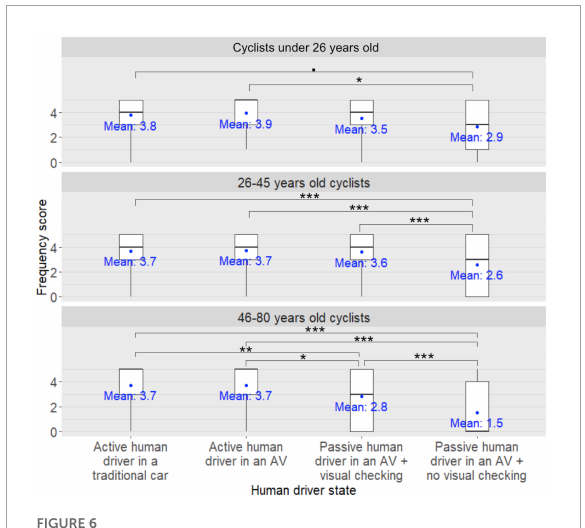
FIGURE6 Human driver state × participant’s age group interaction on the cyclists’ frequency scores to ensure that the human driver has made eye contact in order to take their effective crossing decision • : pFDR < 0.10, *: pFDR < 0.05, **: pFDR < 0.01, ***: pFDR <